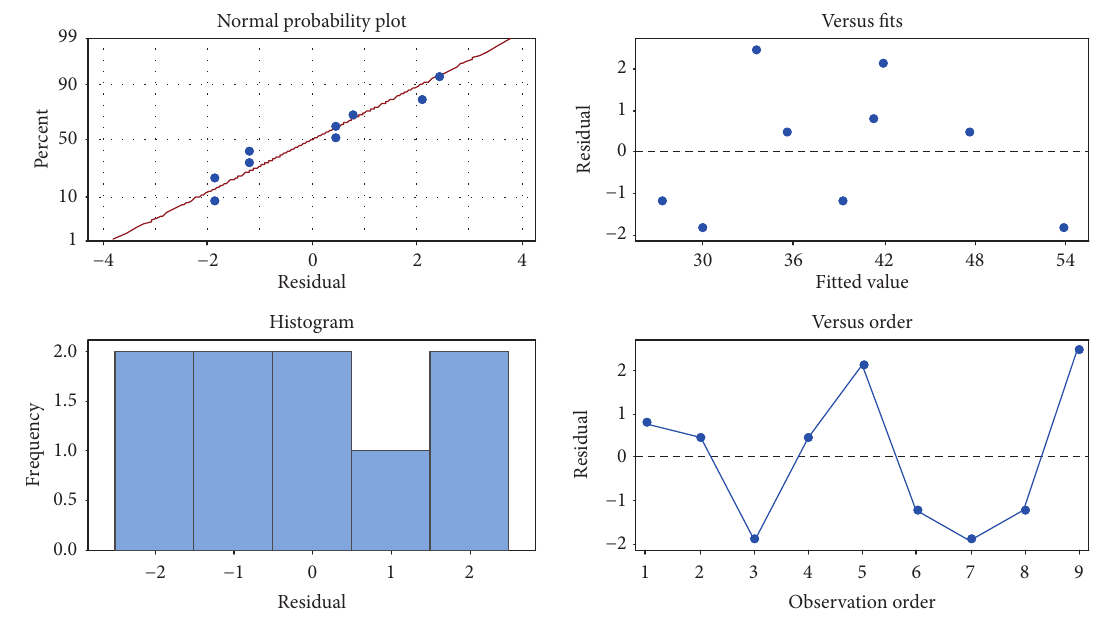
Figure 15: Residual plots for hardness test. Table 16: Analysis of variance for regression model (S/N